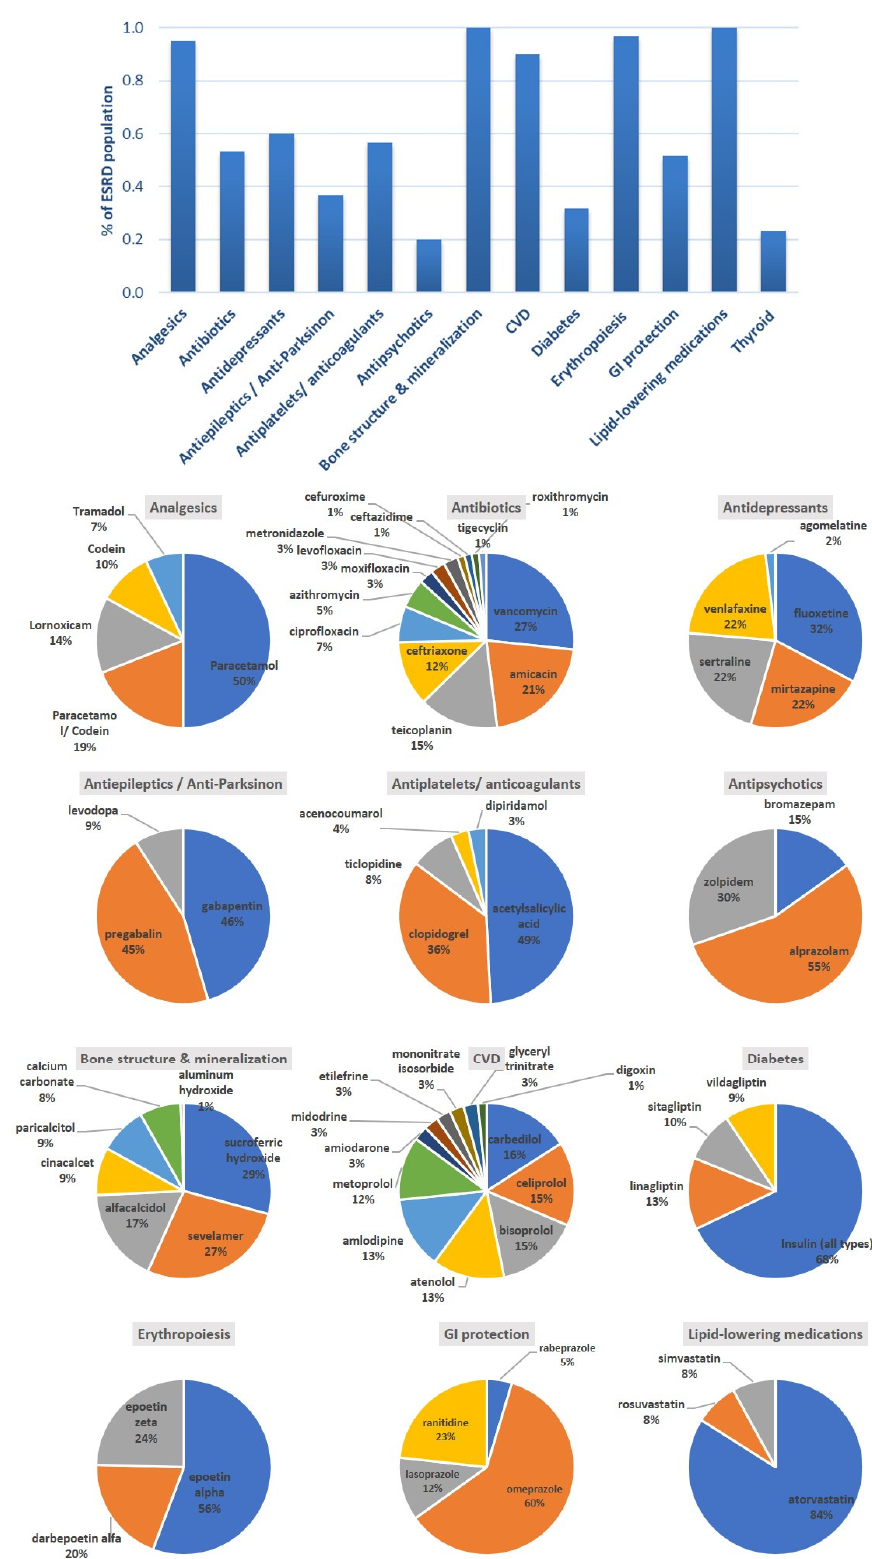
Figure 2. Distributions of medications administered among the ESRD patients. Bar graphs: drug categories among patients; chart pies: pharmacological compounds from each category (Thyroid drugs refer to levothyroxine (100%) alone and not included as pie) (ESRD: End-stage Renal Diseasel CVD: Cardio-Vascular Disease; GI: gastro-intestinal).